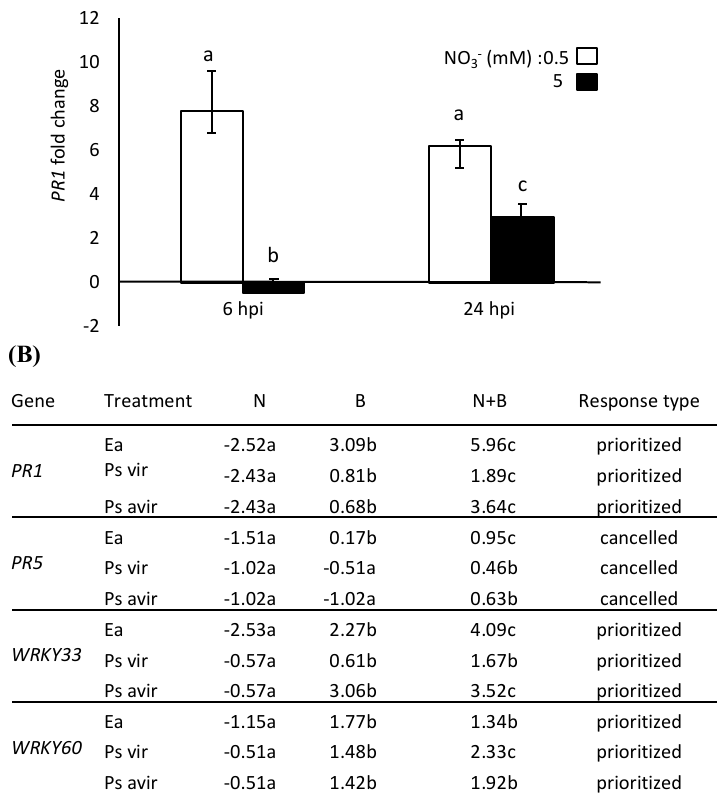
Figure 3. Impact of N supply on defense-related genes expression in response to different bacterial pathogens. ( A ) Time-course of PR1 gene expression at 6 and 24 hpi following mock or Ea treatment. ( B ) Response of selected defense-related genes in response to N, B, and N + B at 6 hpi. ( A , B ) Col-0 plants were grown in full (5 mM) or low (0.5 mM) NO 3− . and infiltrated with bacteria ( Ea wild type, virulent and a virulent strain of P. syringae ) or mock-inoculated. Expression is normalized to the PP2a3 (At1g69960) constitutive gene. Values are log2 signal ratios between infected and mock plants. Similar results were obtained in a minimum of three independent experiments, including three biological replicates each; a representative experiment is shown. The bars represent standard deviation. ( A , B ): Different letters correspond to values that are significantly different according to the Mann–Whitney statistical test ( p- value < 0.05).